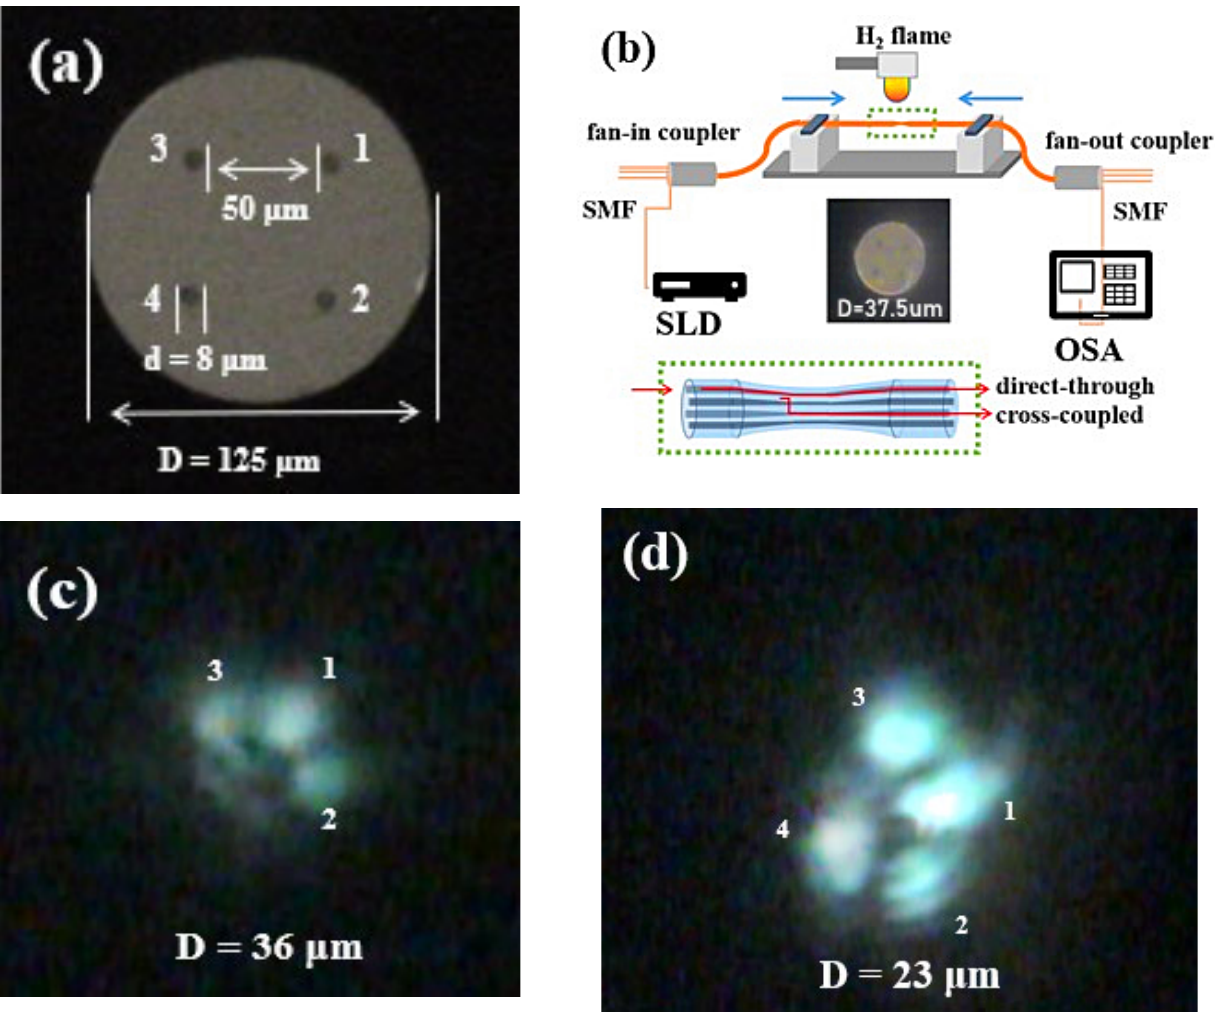
Figure 1. ( a ) Designation of the four cores in the TFCF interferometer, in which the number 1 repre ‐ sents the excitation core, and the numbers 2, 3, and 4 respectively denote cores 2, 3, and 4; ( b ) Ex ‐ perimental setup for fabricating TFCF bending sensors based on the corner excitation scheme. The inset picture is a cross ‐ sectional view of the microphotographs of the TFCF when D = 37.5 μ m under a 1000× CCD microscope; ( c , d ) Mode field distribution of the excited supermodes when ( c ) D = 36 μ m and ( d ) D = 23 μ m.